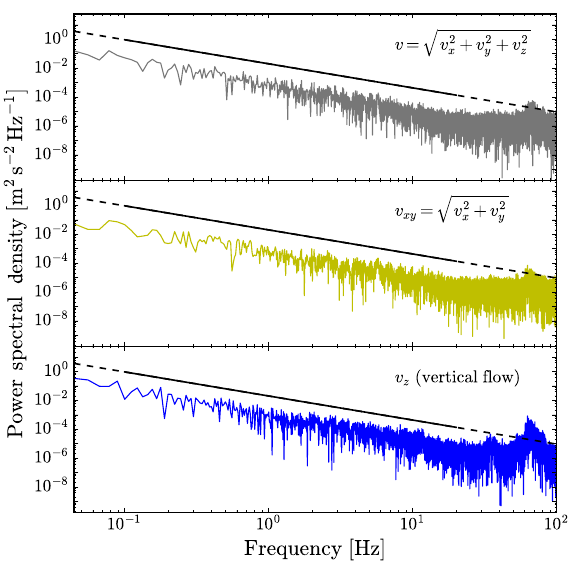
Figure 9. From top to bottom: plots of the power spectral density of the magnitude of velocity ( v ), horizontal velocity ( v xy ), and vertical velocity ( v z ) for the period shown in Fig. 7. No filter was applied to the data used to generate this plot. For reference, a black line is overlaid on each plot and indicates a spectral index of − 5 / 3; this line is plotted solid for frequencies over which it agrees well with the